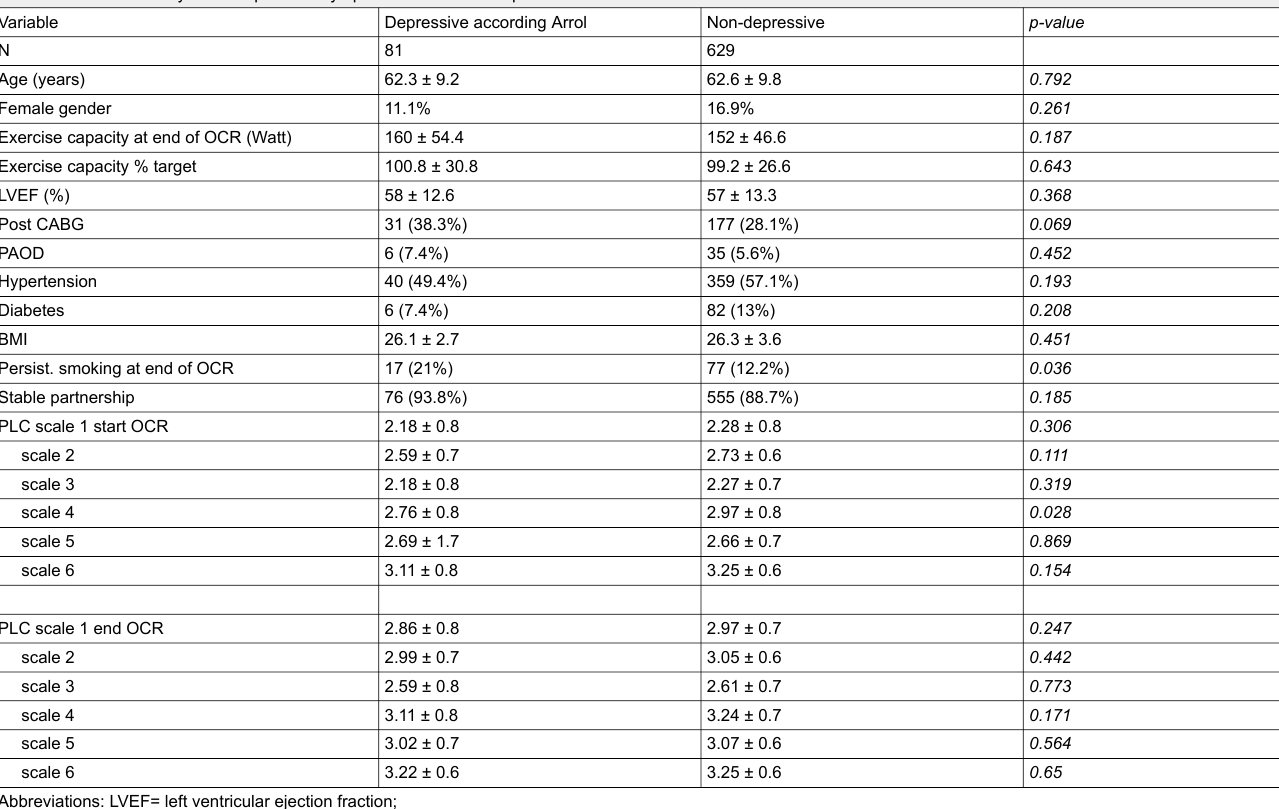
Table 2: Univariate analysis for depressive symptoms at late follow-up.